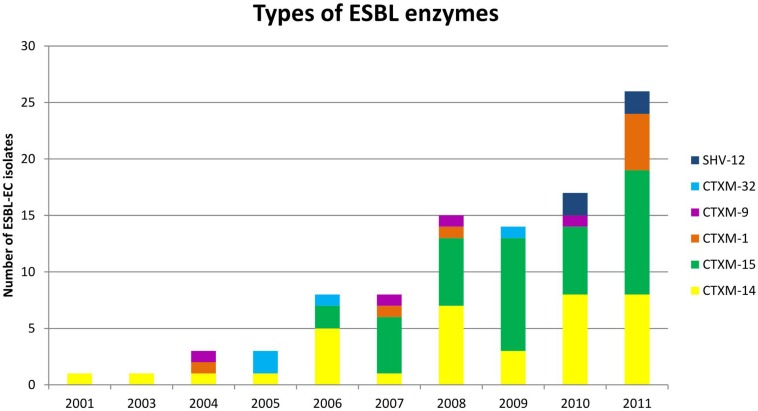
Distribution of extended-spectrum β-lactamase (ESBL) enzymes. Of the 96 ESBL-EC bloodstream isolates, 40 were positive for CTX-M-15, 36 for CTX-M-14, eight for CTX-M-1, and four for CTX-M-9, CTX-M-32, and SHV-12 each.